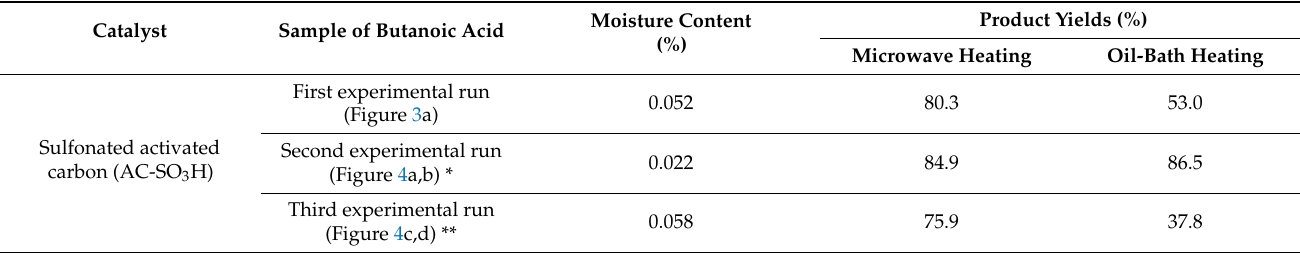
Table 1. Moisture content in the starting butanoic acid samples and conversion yields with microwave and conventional heating methods using both the heterogeneous catalyst (AC-SO 3 H) and the homogeneous catalyst (TMP-PTS).